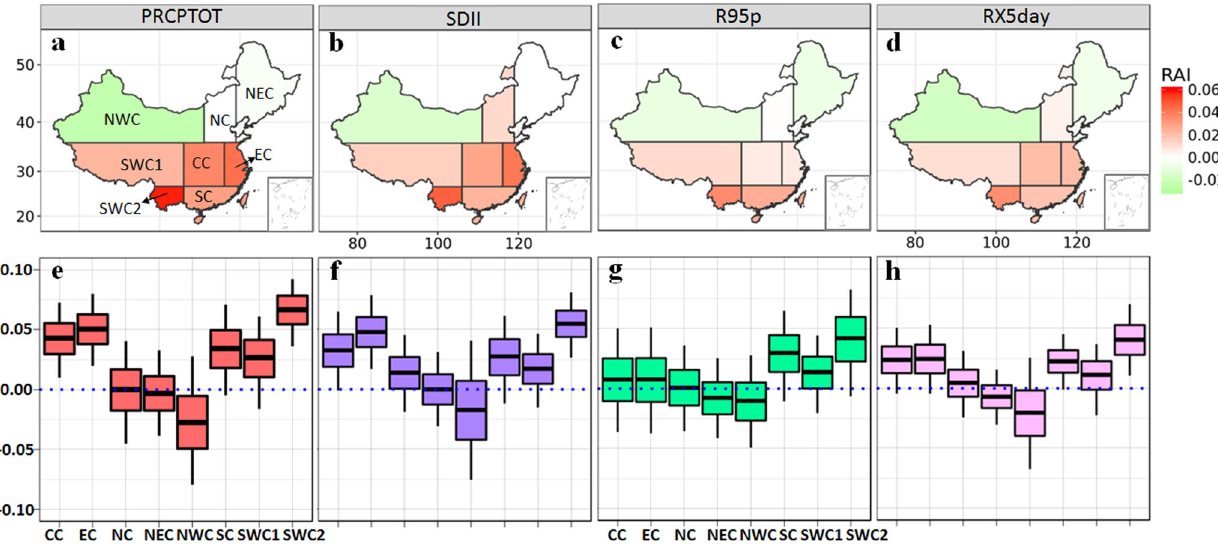
Fig. 3 Maps of the RAI estimates. a – d The best temporal RAI estimates over eight regions in China for PRCPTOT (mm/year), SDII (mm/day), R95p (mm), and RX5day (mm) respectively. e – h The uncertainty range (5th to 95th percentile) of RAI and the horizontal line in the box represents the best estimate (i.e., median value). The sub fi gures were done in the software R 4.0.2 (https://cran.r-project.org/bin/windows/), and then the sub fi gures were merged by using the Microsoft PowerPoint 2013 software (https://www.microsoft.com/).